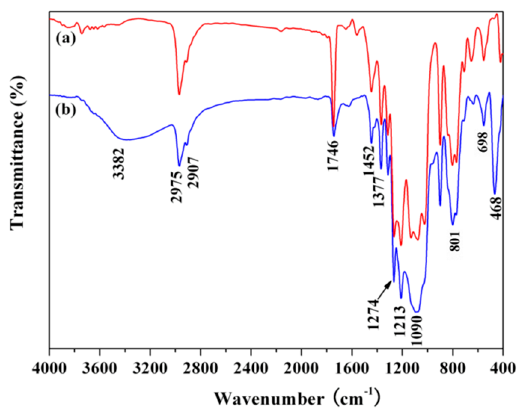
Figure 2. The infrared spectrograms of PFAS (a) and PFAS-SiO 2 (b).